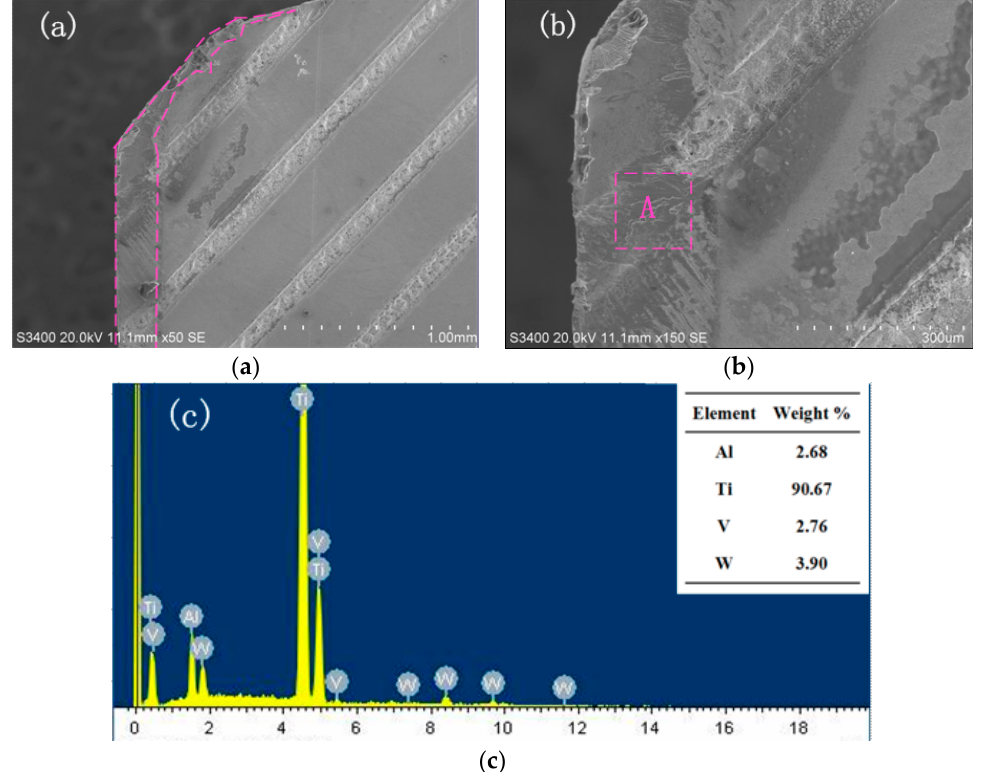
Figure 7. SEM and EDX of wear at the rake face of line textured tool ( v = 90.4 m/min, a p = 0.4 mm). ( a ) Wear morphology; ( b ) Enlarged morphology; ( c ) EDX of zone A.